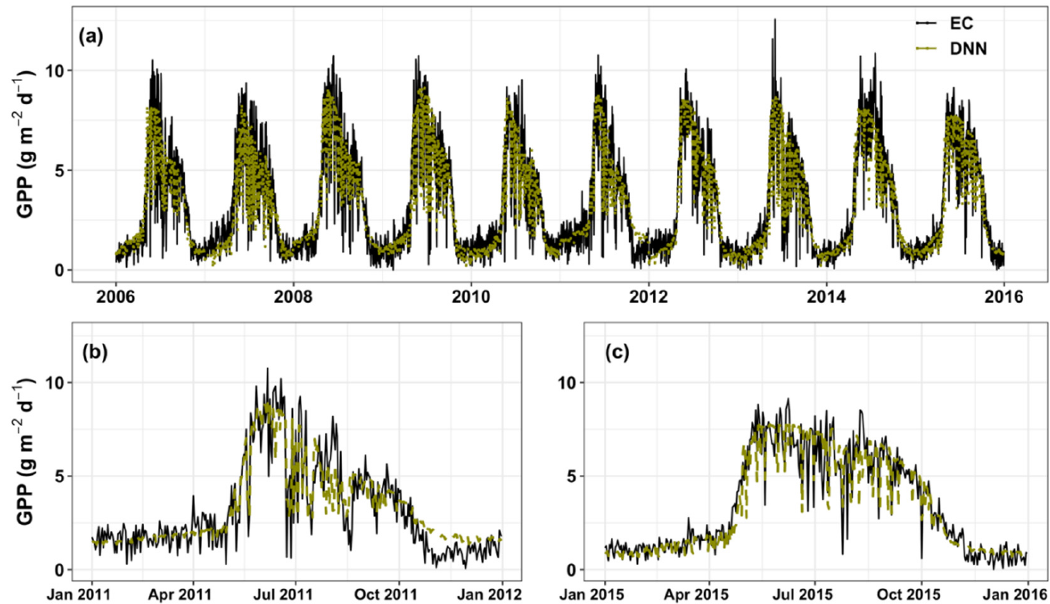
Figure 6. Observed vs. predicted daily gross primary productivity (GPP) by an artificial neural network (ANN) model at the Gwangneung site during 2006–2015 ( a ), and the predictions zoomed-in for 2011 ( b ) and 2015 ( c ).